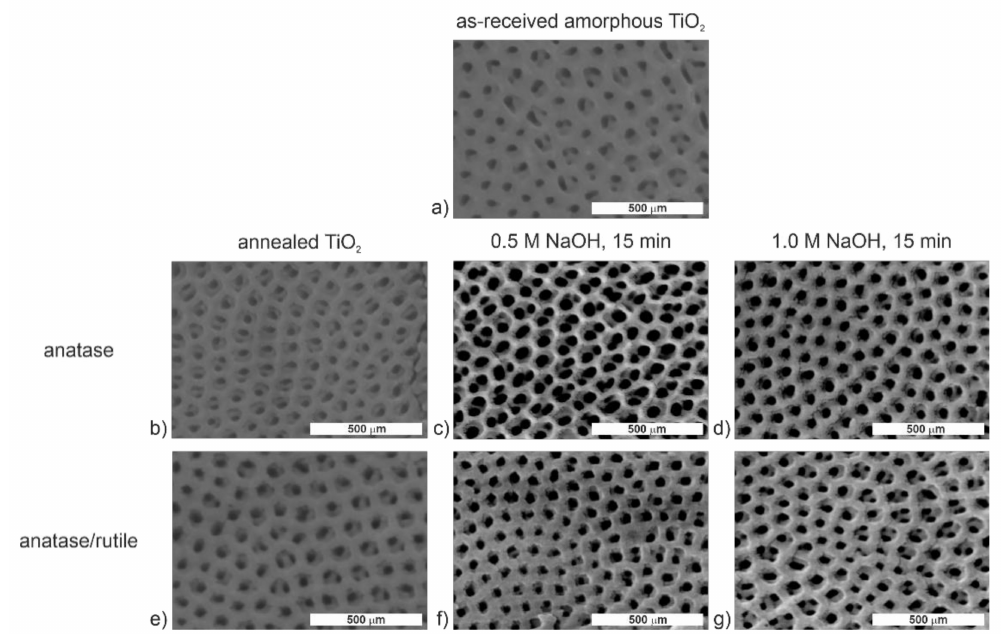
Figure 1. FE-SEM images of nanoporous TiO 2 layers non-modified ( a , b , e ) and modified with 0.5 M ( c , f ) or 1.0 M ( d , g ) NaOH for 15 min. The TiO 2 layers were non-annealed ( a ) and annealed at 400 ( b – d ) or 600 ◦ C ( e – g ) for 2 h before the surface modification with